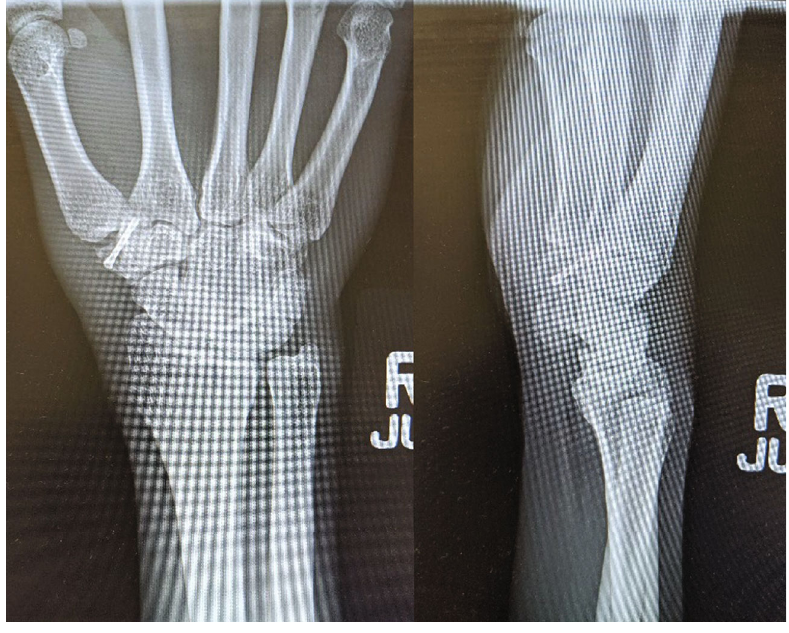
Figure 4: At 3 months follow-up, healing of the fracture demonstrated.